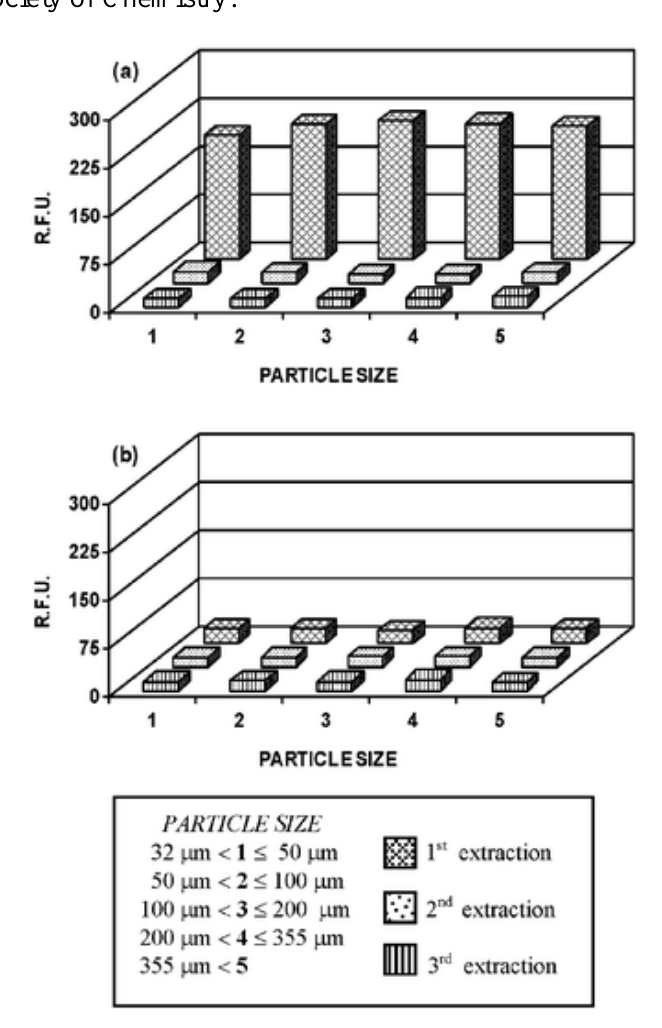
Figure 7. Fluorescence intensity of washing solutions containing estradiol extracted from imprinted ( a ) and non-imprinted ( b ) polymers having different size particles using microwave-assisted extraction (MAE). Reprinted from Bravo et al. [52] with permission from the Royal Society of